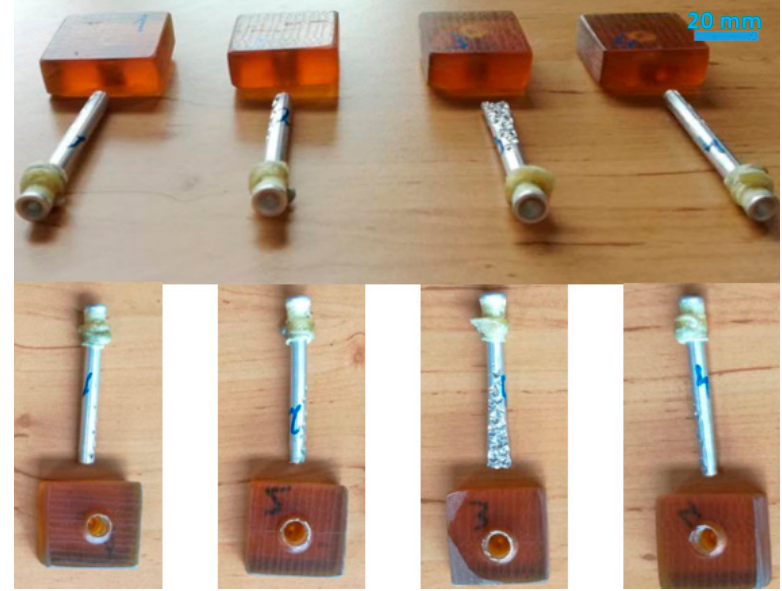
Figure 6. Tested specimens displaying full rivet pullout